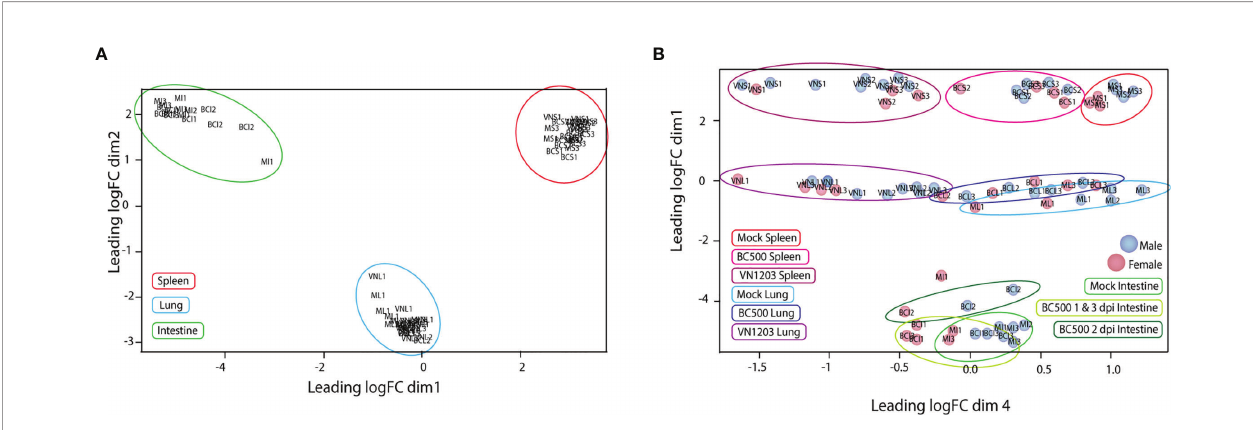
FIGURE 1 | Multidimensional scaling (MDS) plot of normalized individual RNA-sequencing experiments. MDS plots were made in the EdgeR program comparing the top 200 logFC results between each sample. Individual samples and their relative similarity and differences were compared using dimensions 1 and 2 (A) and dimensions 1 and 4 (B) . Individual plot points were named by treatment (VN, VN1203; BC, BC500 and M, Mock), tissue (L, Lung; S, Spleen and I, intestine) and dpi (1, 2 and 3). Ex: Spleen from mock treated duck 1 dpi = MS1. Individual male ducks are identi fi ed by a blue dot and females by a red dot.